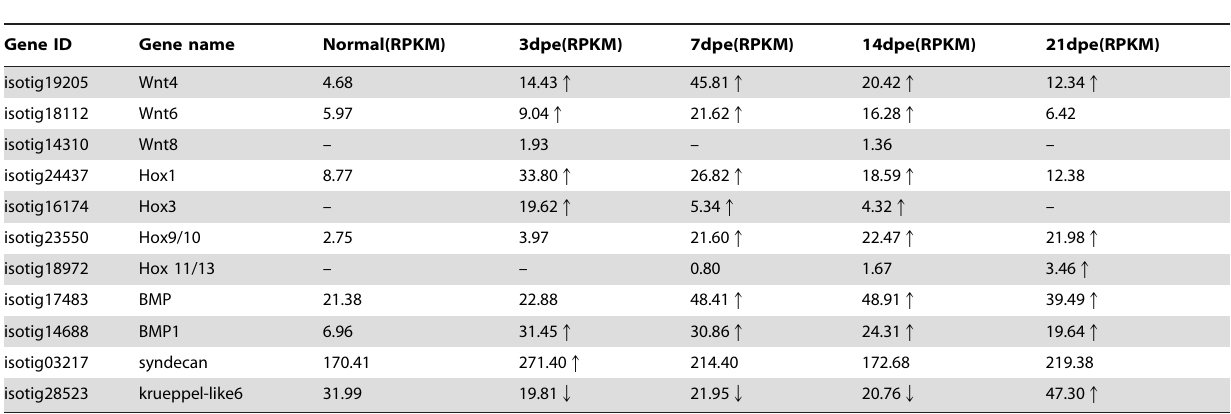
Table 10. Expression profile of developmental genes during intestine